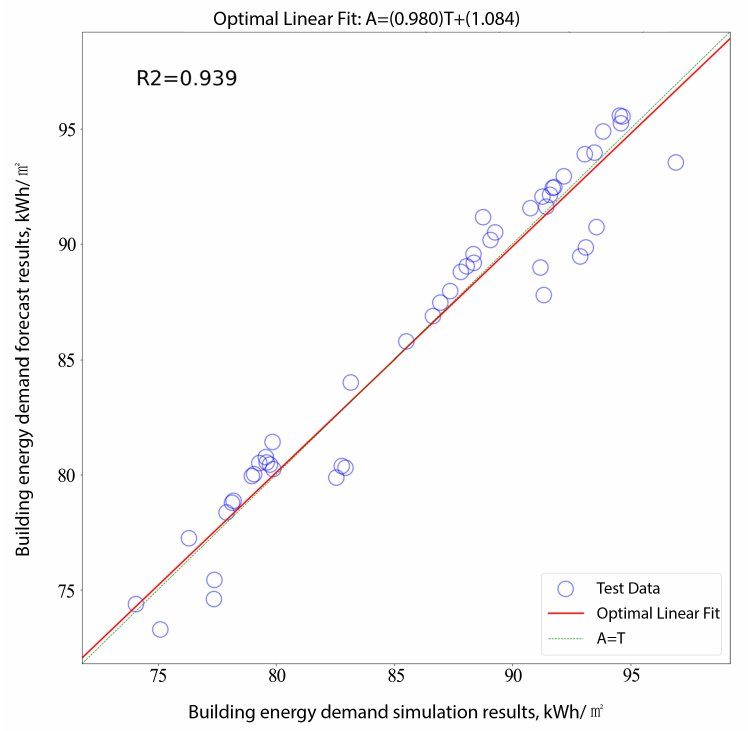
Figure 16. Prediction model of building energy demand.